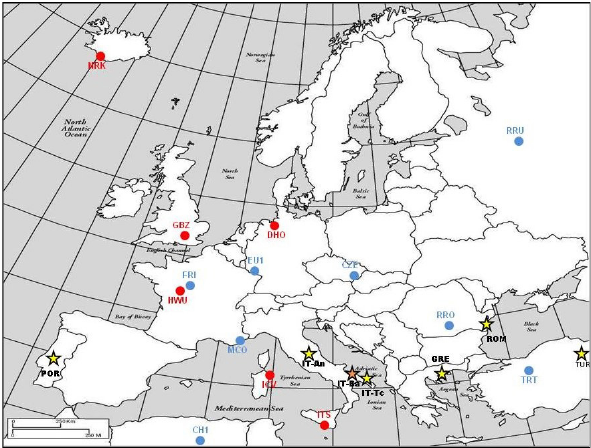
Fig. 2. Map showing the receivers and transmitters of the network. The stars show the locations of the VLF/LF receivers. The orange star represents the OmniPal type; the yellow ones represent the Elet- tronika type. The circles on the map indicate the LF (blue) and VLF (red) transmitters, the signals of which are collected by the different receivers. Some peculiarities of these transmitters are reported